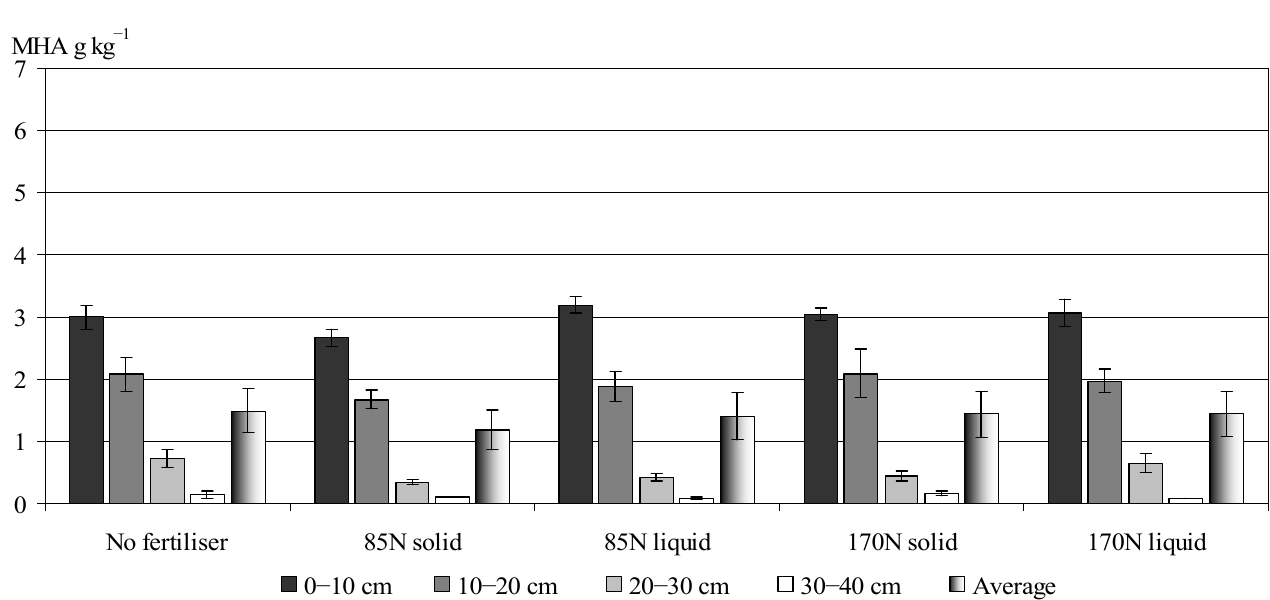
Figure 15. MHA content in the grassland in Fluvisol, 2020 .